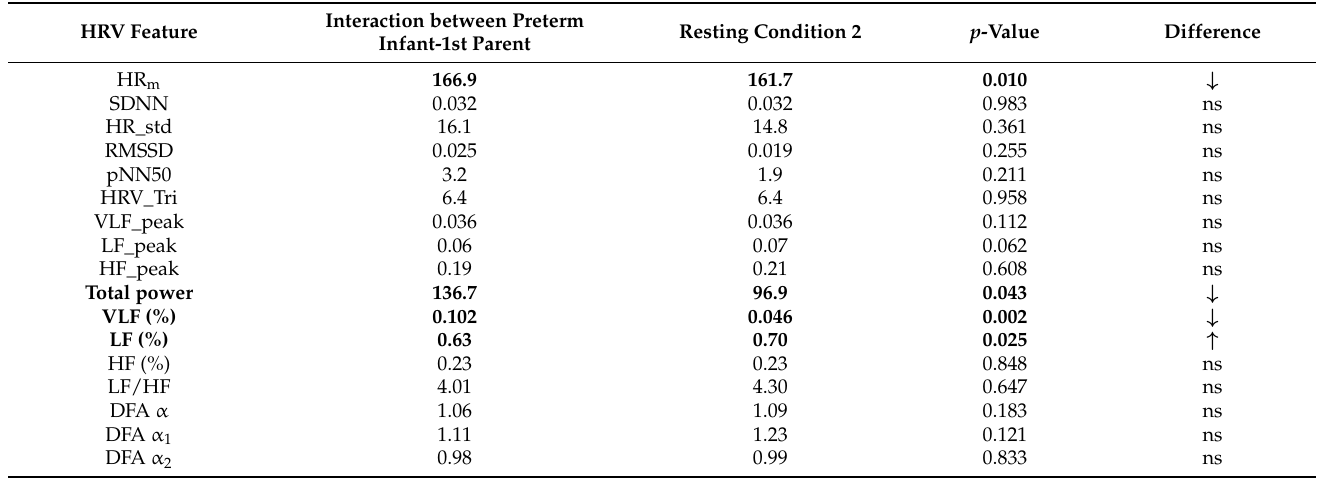
Table 7. Comparison of preterm infants’ HRV parameters between interaction with the 1st parent and resting condition